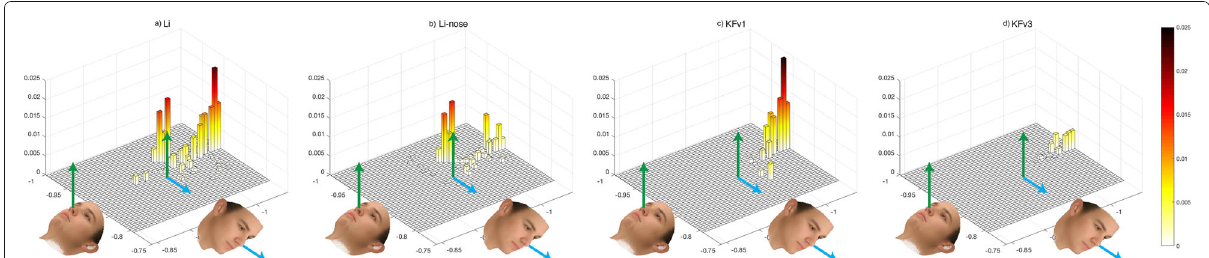
Fig. 16 2D histogram of the missed detection distribution on sequence BIWI 24. Results using a Li’s approach, b Li’s proposal including of nose detection heuristic, and c our KF-based method without optimization (KFv1) and d our KFv3 proposals